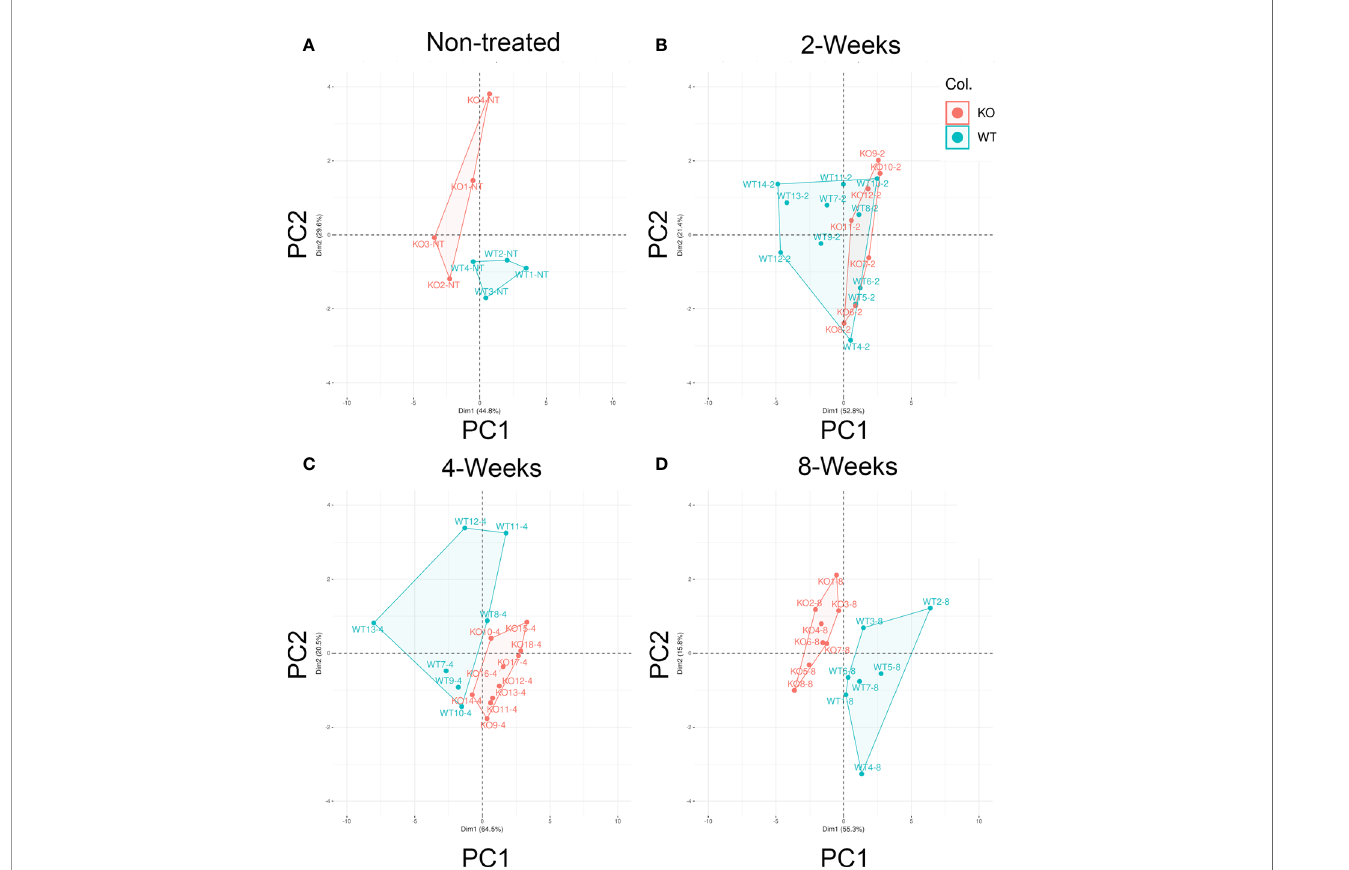
FIGURE 6 | Distinct clustering of Cd38 − / − cGVHD mice. The PCA score plots show the distribution of mice according with two principal components that accumulate the greatest variance (71% – 85% range) of the 11 features (variables) tested. Principal component 1 (PC1, x -axis) X% and principal component 2 (PC2, y -axis) Y%. Each panel represents one given time. (A) Non-treated (NT) healthy mice ( n = 4, per mouse). (B) Two-weeks cGVHD ( n = 11, WT; n = 7, KO). (C) Four- weeks cGVHD ( n = 7; WT; n = 10, KO). (D) Eight-weeks cGVHD ( n = 7, WT; n = 8, KO). Each dot represents an individual mouse, and except for NT, they are representative of two or more experiments. WT samples are represented by fi lled red circles. Cd38 − / − samples with fi lled green